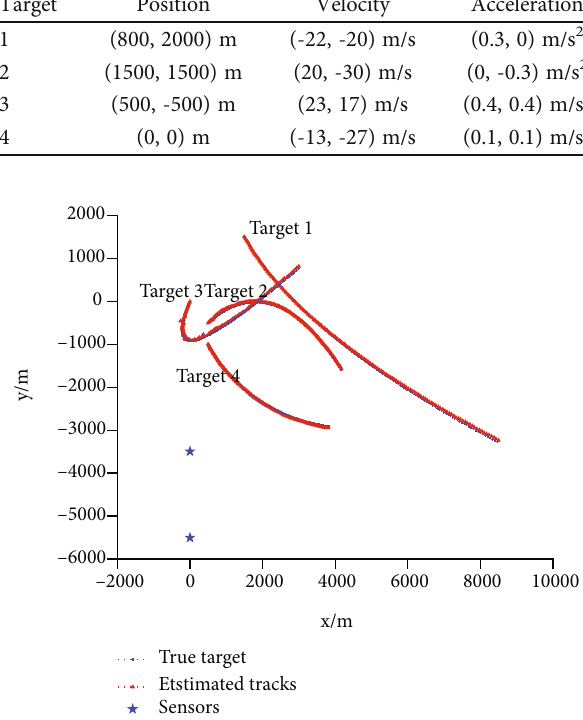
Figure 9: The tracking scenario of multiple targets, given two passive static sensors, CA model, true target trajectories, and estimated tracks.